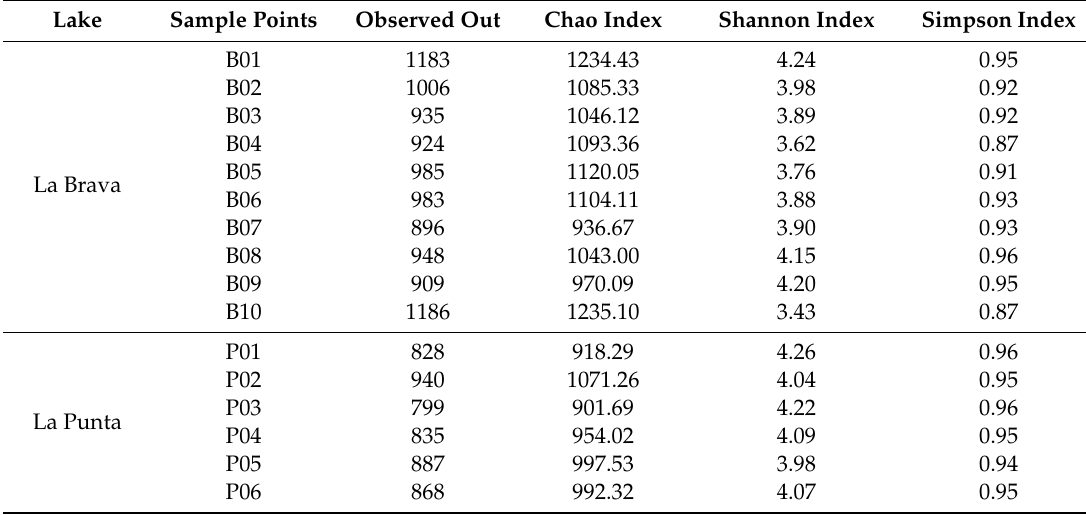
Table 3. Alpha diversity of the water column samples based on amplicon sequencing of the 16S rRNA gene hypervariable V3 and V4 regions (at ≥ 97%